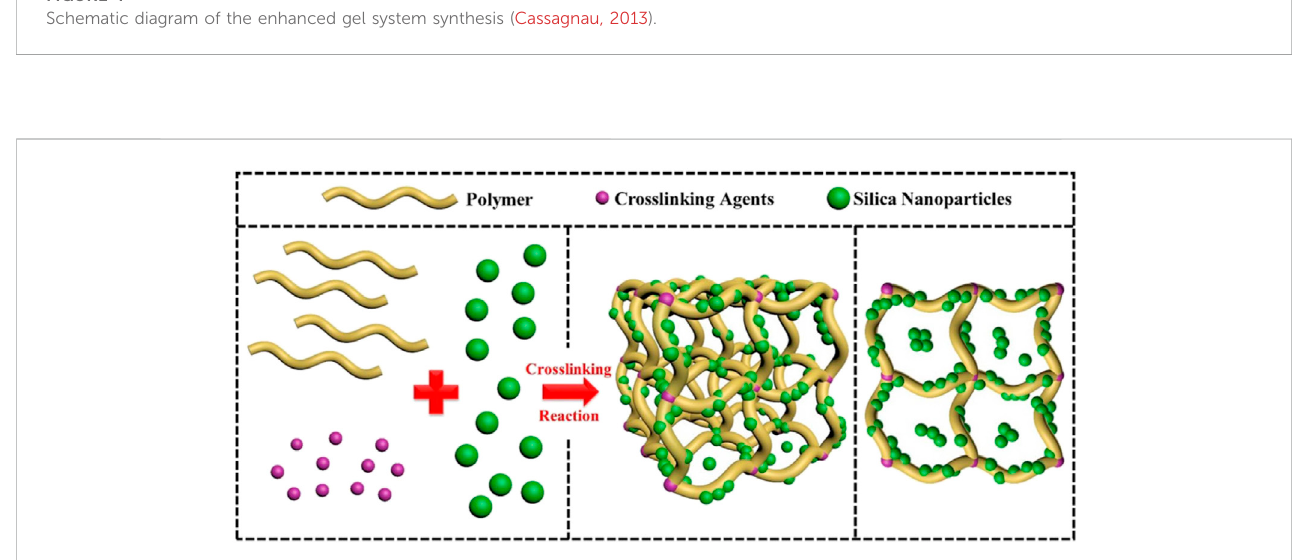
FIGURE 5 Strengthening mechanism of nano-silica particles to gel strength (Liu et al., 2017).